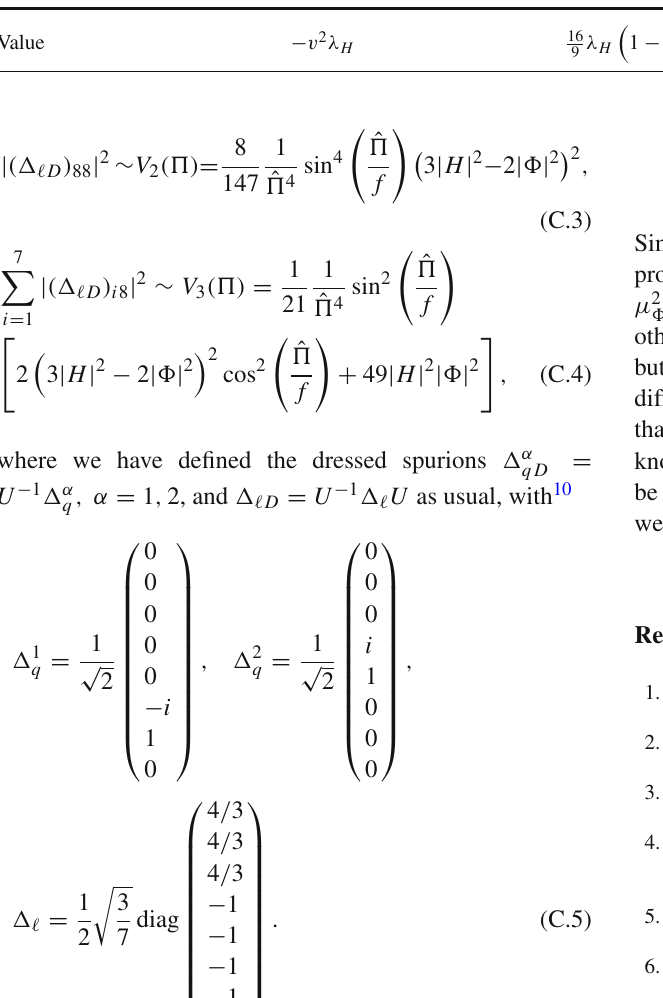
Table 2 Values of the different parameters of the renormalizable scalar potential as a function of f , to order O (v 2 / f 2 ) . v ∼ 246 GeV and λ ∼ 0 . 13 stand for the SM EW VEV and the Higgs quartic coupling, respectively H Parameter